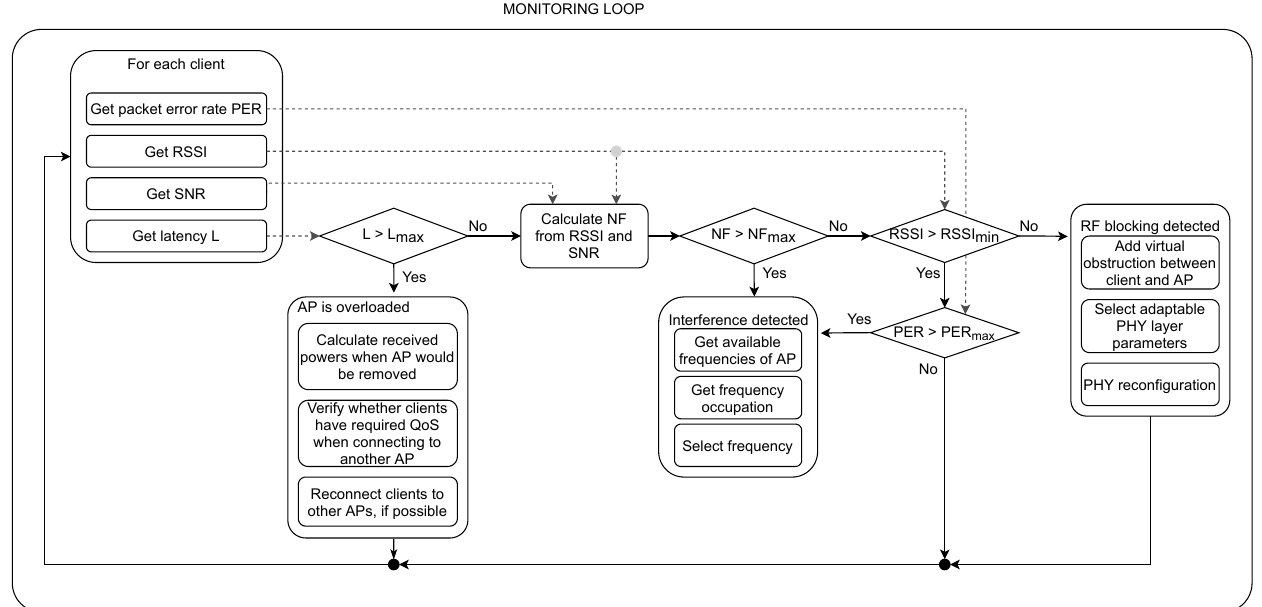
Figure 4. Monitoring algorithm: monitor packet error rate (PER), received signal strength information (RSSI), signal-to-noise ratio (SNR), and latency (L), and a PHY reconfiguration is triggered when QoS requirements are not